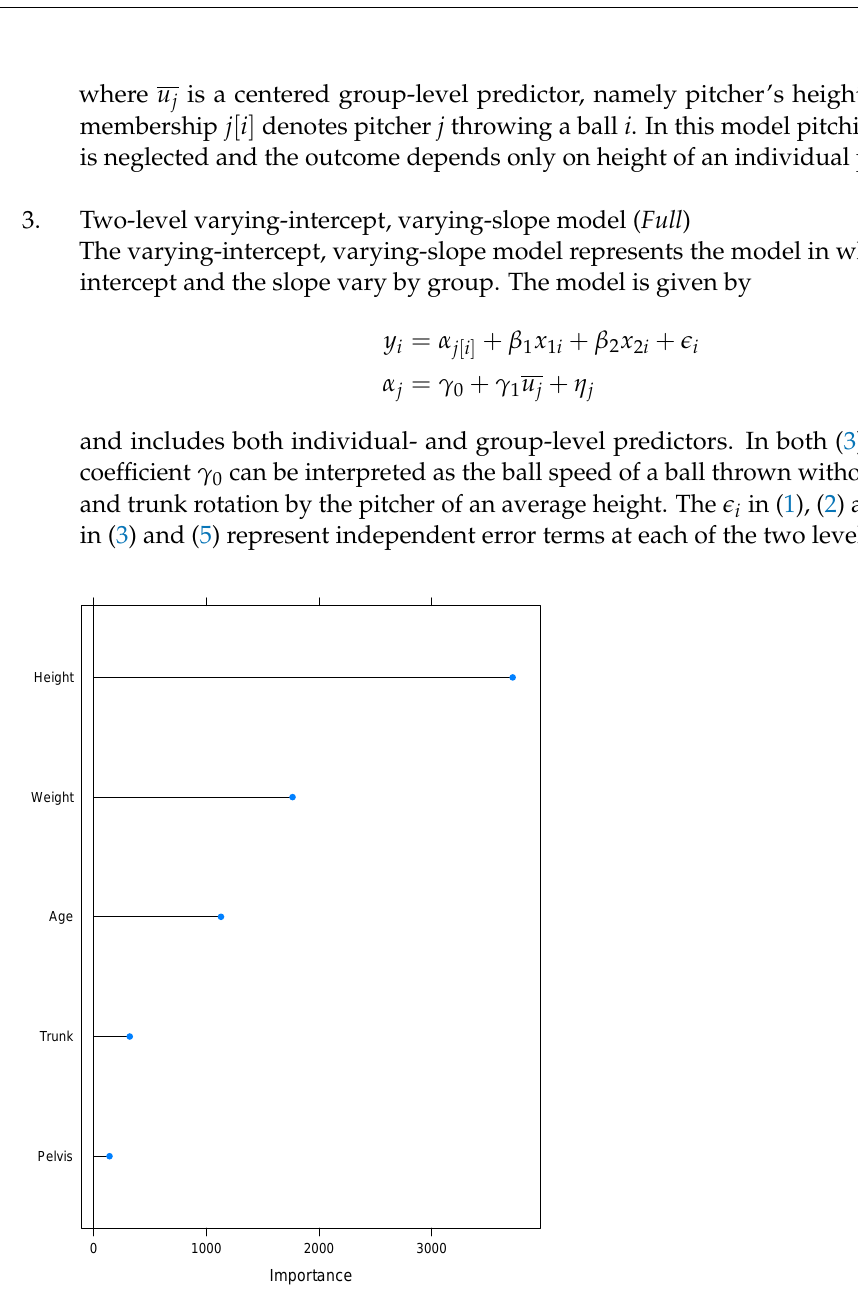
Figure 3. Visual representation of the variable importance calculated by applying random forest. The horizontal axis should be interpreted as a measure for relative importance of predictive variables. The figure reveals Height to be the most important predictor for ball speed which is, therefore, selected as group-level